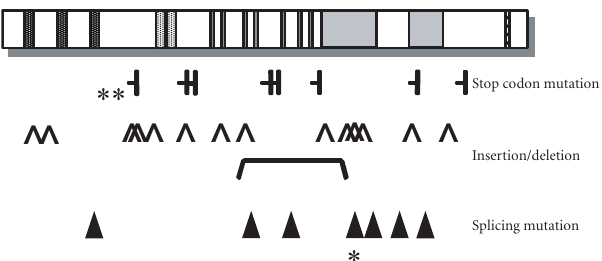
Figure 2. WRN mutations in WS patients. The rectangular boxes indicate the functional domains of the WRN protein (see Figure 1). Known WRN mutations are grouped based upon the type of mutation, shown above and underneath the WRN protein diagram along with Registry codes. Parenthe- ses indicate the heterozygous mutations. R367Stp ( ∗∗ ) is the most common mutation seen in Caucasian WS patients (approximately 25%) and the sec- ond most common mutation in Japanese WS patients (approximately 18%) [33]. Deletion of exon 26 ( ∗ ), which is due to a splice junction mutation, is the most common mutation in Japanese WS patients (approximately 52%)